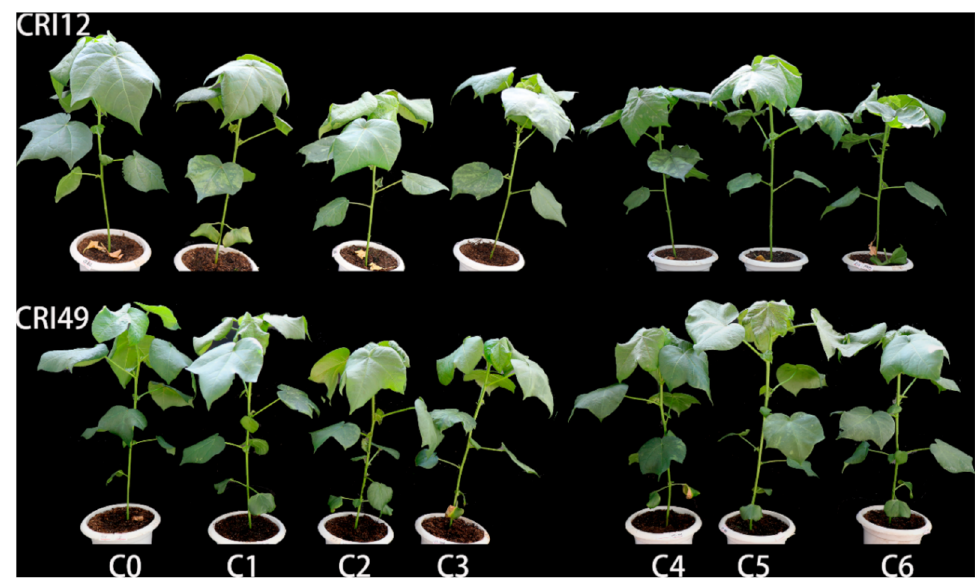
Figure 3. Phenotype of leaf abscission induced by TDZ (0, 100, 200, 300, 400, 500, 1000 mg L − 1 ) in CRI 49 and CRI 12 at 2 days after treatment at the seedling stage. Scale bars are 12 cm.